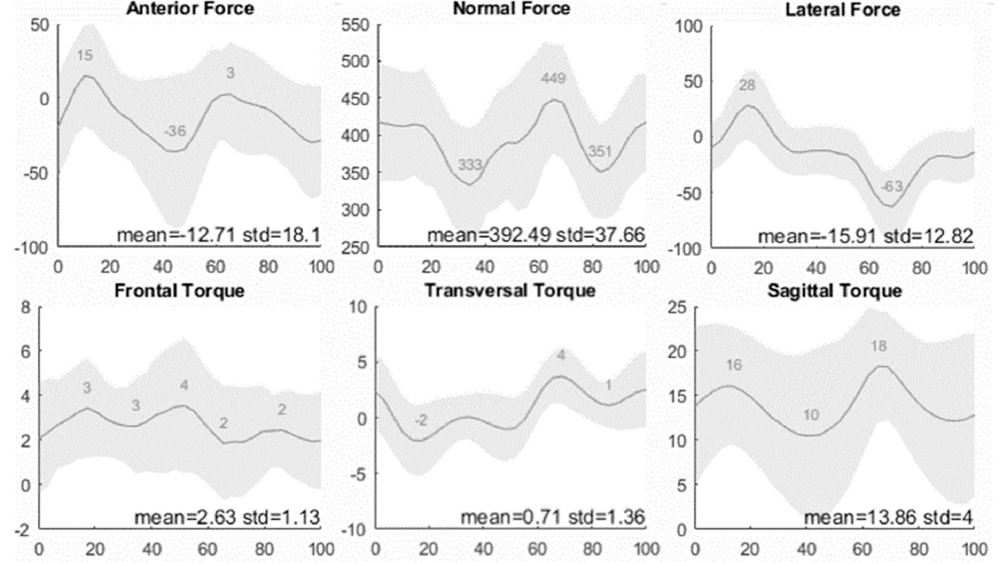
Figure 5. Seat forces (N) and torques (Nm) expressed in function the pedal cycle (%). The normal axis represents the seat load expressed in Newton, and the horizontal axis represents the phase of the pedal cycle, wherein the right pedal starts (0%) and ends (100%) in the upper normal position (dead center). The grey area represents the variation. The Anderson–Darling Test for a Normal Distribution fails to reject the null hypothesis, which states that the data comes from a normal distribution at a 5% significance level; therefore, it can be concluded that 95% of the data are situated in the gray area.